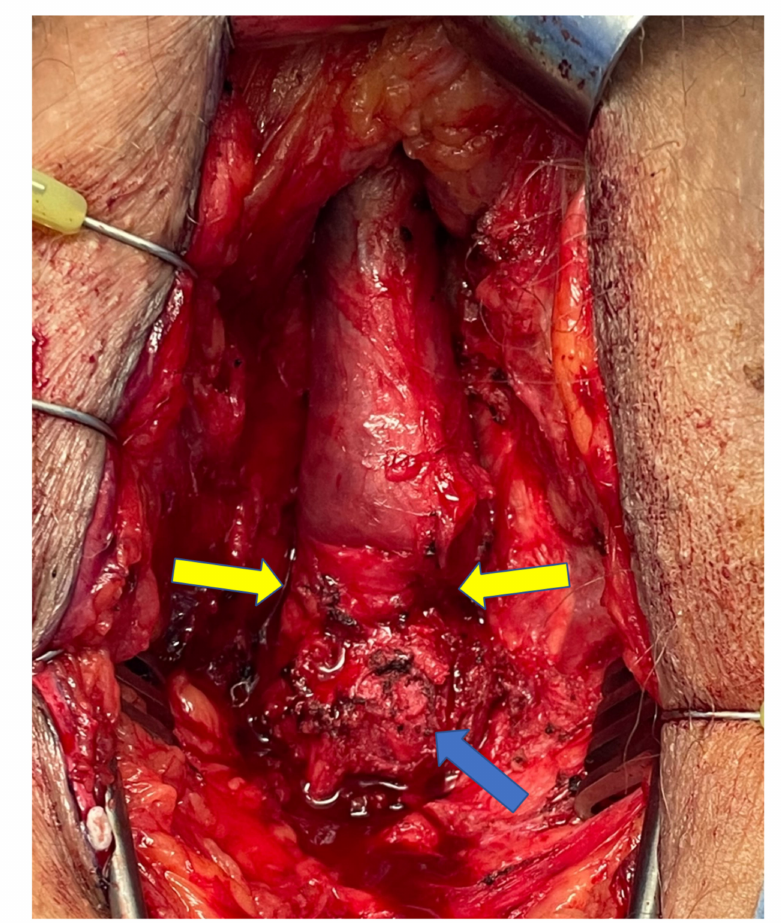
Figure 2. Urethral atrophy after sling placement: The sling (AdVance) is located at the bulbar urethra (blue arrow). Note the caliber change of the urethra distal to it, indicated by yellow